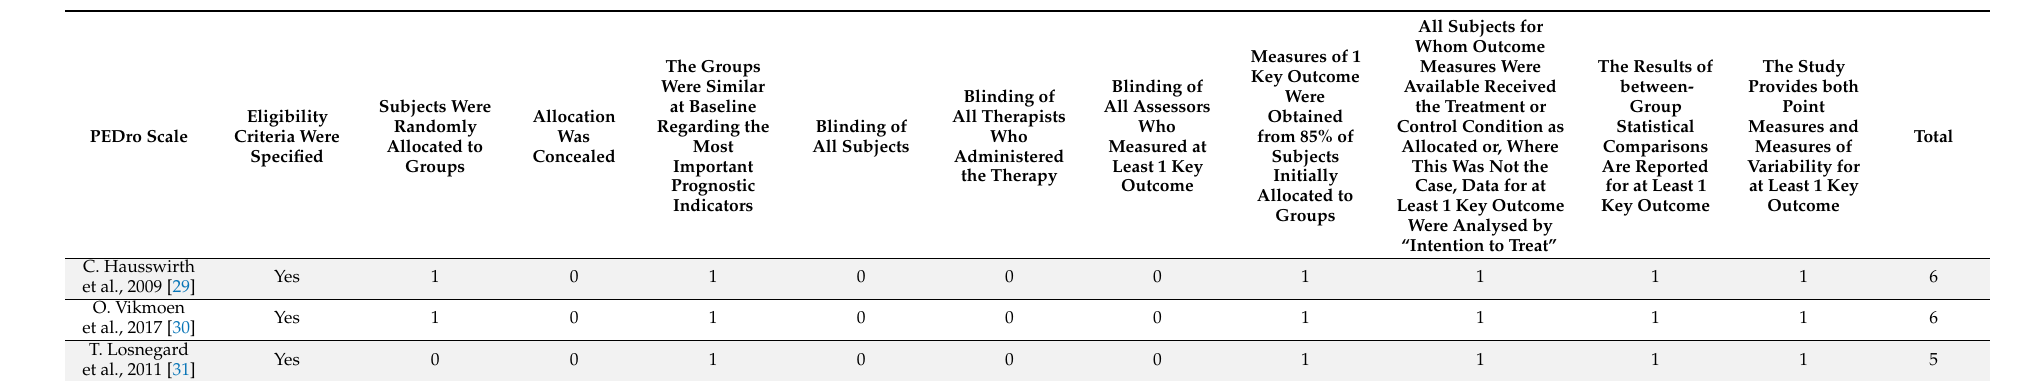
Linked table footnotes: Items in the PEDro scale. 1 = eligibility criteria were specified; 2 = subjects were randomly allocated to groups; 3 = allocation was concealed; 4 = the groups were similar at baseline regarding the most important prognostic indicators; 5 = blinding of all subjects; 6 = blinding of all therapists who administered the therapy; 7 = blinding of all assessors who measured at least 1 key outcome; 8 = measures of 1 key outcome were obtained from 85% of subjects initially allocated to groups; 9 = all subjects for whom outcome measures were available received the treatment or control condition as allocated or, where this was not the case, data for at least 1 key outcome were analysed by “intention to treat”; 10 = the results of between-group statistical comparisons are reported for at least 1 key outcome; 11 = the study provides both point measures and measures of variability for at least 1 key